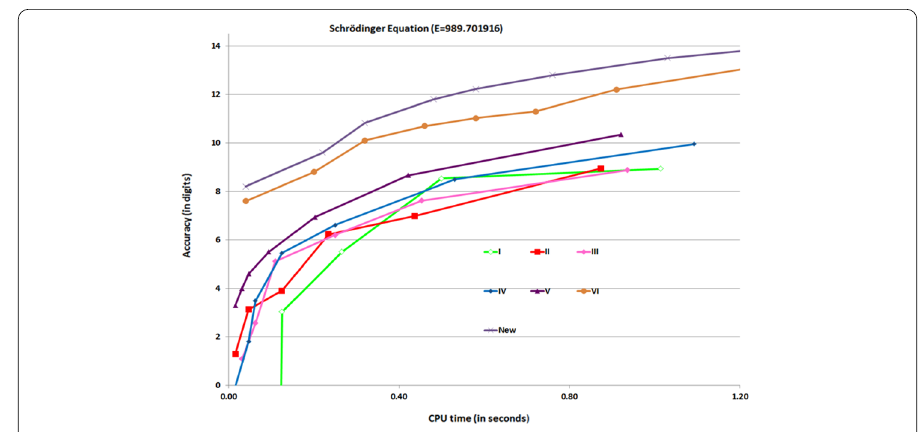
Figure 4 Digits of accuracy versus CPU times (in seconds) for different methods, corresponding to the eigenvalue E